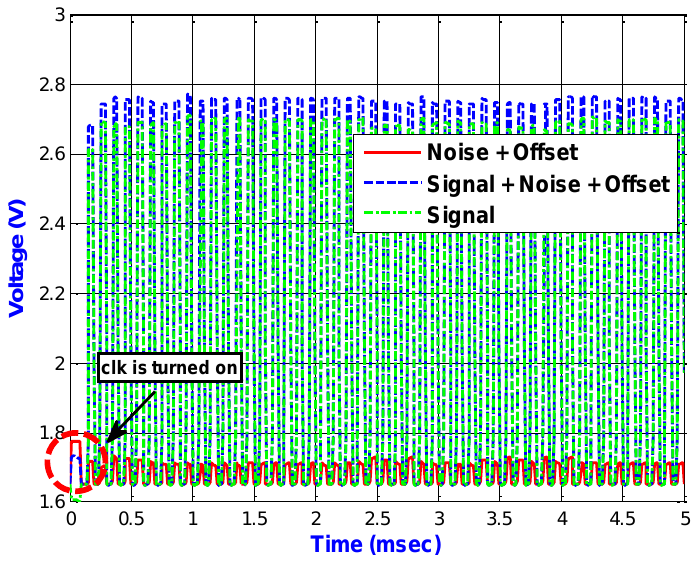
Figure 16. Output voltage using signal processing.